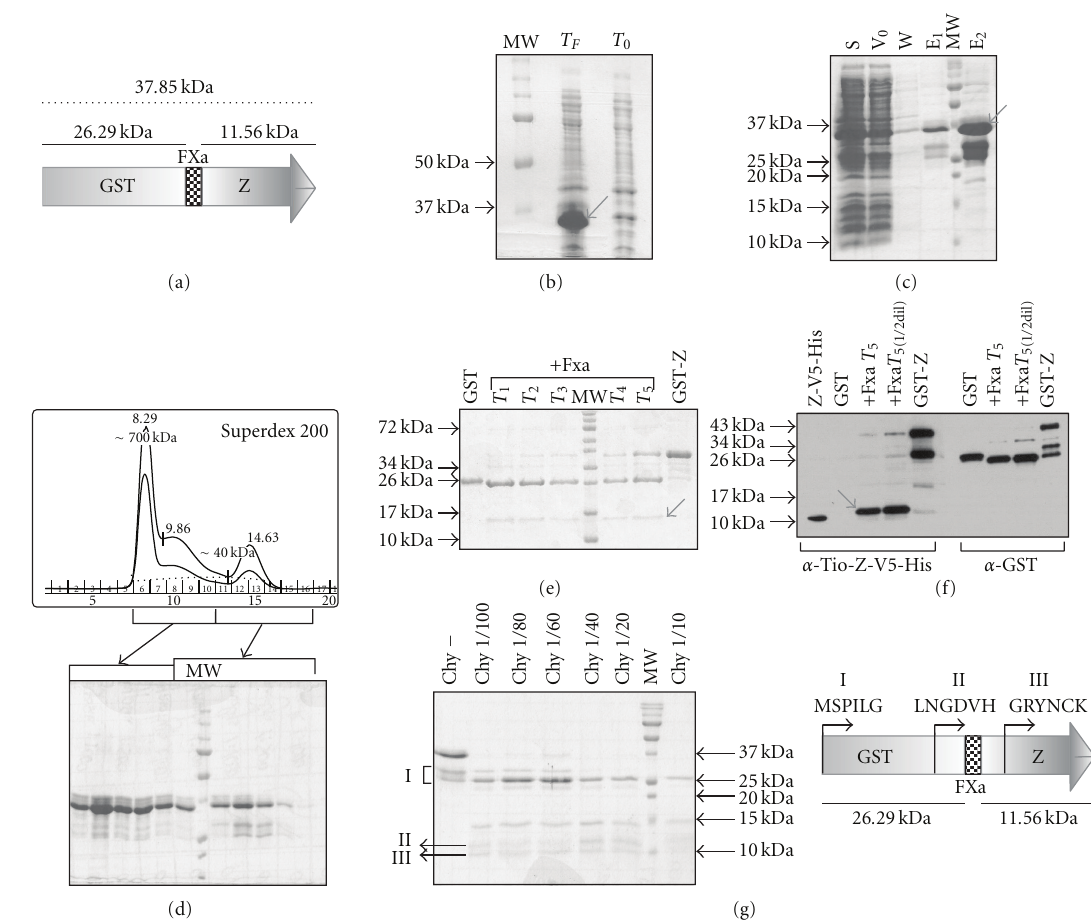
Figure 3: Expression, Purification, and Cleavage of GST-Z . (a) Diagram of the recombinant GST-Z protein expressed in E. coli . The dark gray region represents the glutathione-S-Transferase (GST) fusion protein; the striped block indicates the specific protease Factor Xa. (IleGluGlyArg ↓ ) target sequence; and the light gray arrow shows the Z protein. The molecular weight of the complete recombinant protein is approx. 37 kDa, the cleavage products being ca. 25 kDa (GST) and ca. 11 kDa (Z). (b) 12% SDS-PAGE of a sample of the whole cell culture at initial time ( T 0 ) and after 20h at 20 ◦ C ( T F ). (c) 15% SDS-PAGE of the purification of GST-Z with glutathione Sepharose 4B (Amersham). S : Supernatant from the whole cell lysate expressing GST-Z; V 0 : Lysate that ran through the column upon loading; W : Wash with PBS; E 1 and E 2 : elution with 1 X PBS plus 25mM reduced glutathione (Sigma). The arrow indicates GST-Z (37 kDa). (d) Gel Filtration (Superdex 200 GL, Amersham) and 12% SDS-PAGE. The first peak on the chromatogram includes fractions 6 to 10, analyzed in the SDS- PAGE, while the second peak corresponds to fractions 11 to 16. (e) 16% SDS-PAGE GST-Z cleavaged with the protease Factor Xa. The arrow indicates the cleavage product corresponding to Z (cid:3) (11.56 kDa). T 1 : 1h; T 2 : 2h; T 3 : 4h; T 4 : 6h; and T 5 : 16 h, at 37 ◦ C. (f) Western-blot of the cleavage products of GST-Z with Factor Xa. The arrow indicates the Z (cid:3) protein. (g) 15% SDS-PAGE of the limited proteolysis of GST-Z with Chymotrypsin (Roche). The protein products indicated with the symbols I, II, and III were sequenced at the N-terminus. The obtained sequence is indicated adjacent to the diagram of GST-Z.